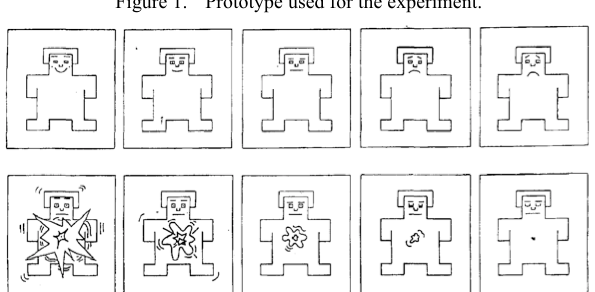
Figure 1. Prototype used for the experiment.